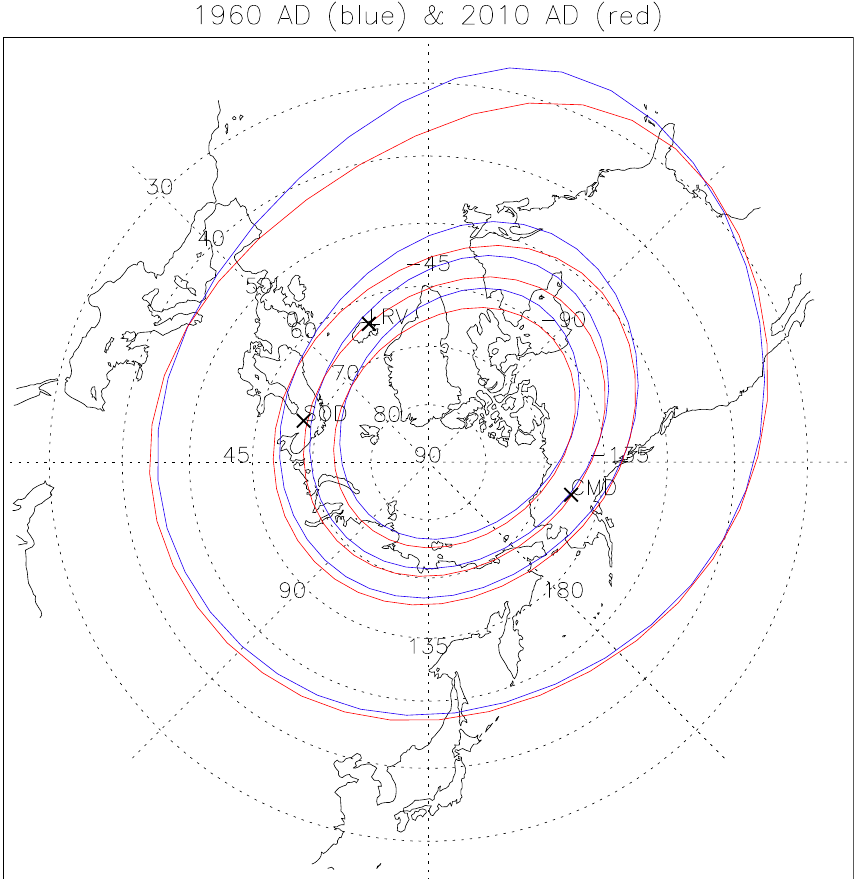
Fig. 1. Reconstructed global shape of the auroral zone in 1960 AD (blue) and 2010 AD (red). Contours are apex fi eld intensities of 49, 173, 474, and 6178 nT, corresponding to 70, 65, 60, and 40 magnetic latitudes. Japan ’ s longitude (135 (cid:1) E) is toward the bottom. The positions of LRV (Leirvogur, Iceland), SOD (Sodankylä, Finland), and CMO (College, Alaska) are marked by